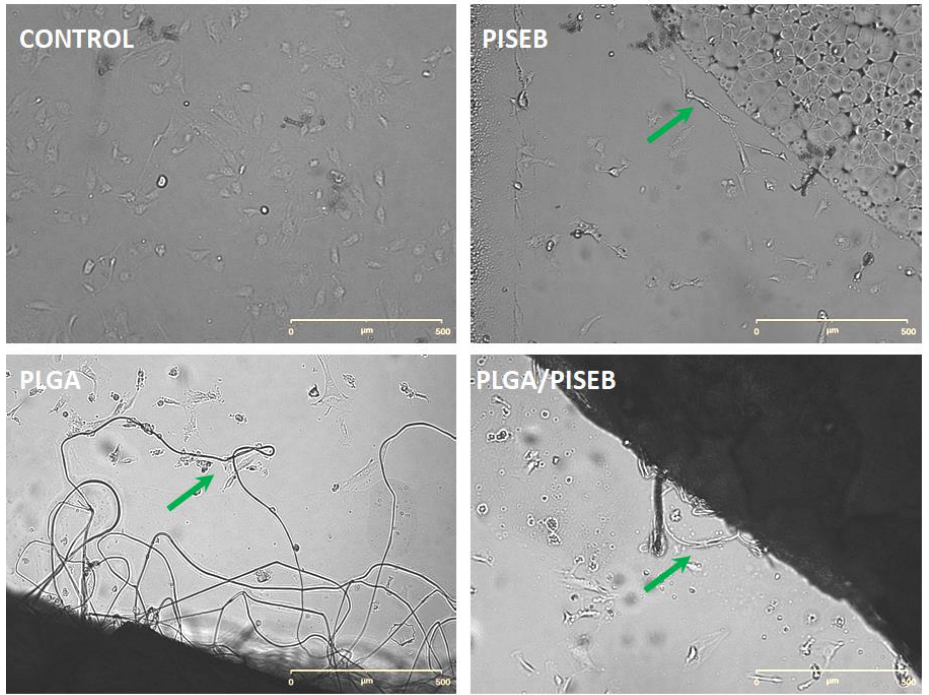
Figure 7. Typical images of HUVEC cells cultured on VEGF-supplemented EGM-2 medium for 48 h on control polystyrene plate and tested materials: drop-casted PISEB, electrospun PLGA, and electrospun PLGA/PISEB. Tubular and spindle-like shapes presented in visible light are indicated by green arrows (scale bar 500 µ m; magnification 40×; JuLI_FL ™ apparatus).